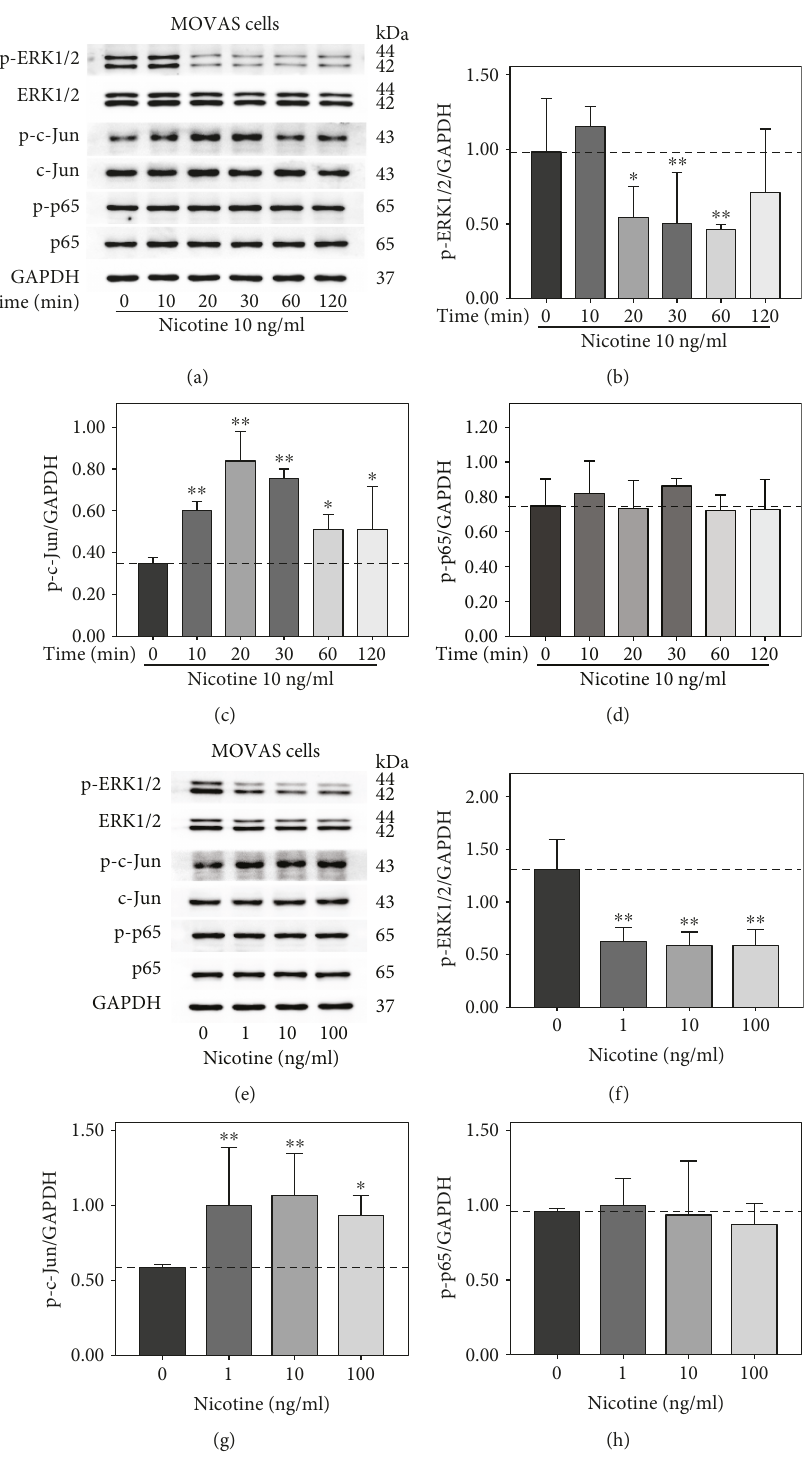
Figure 3: Nicotine increased the phosphorylation of c-Jun in MOVAS cells. (a) MOVAS cells were exposed to 10 ng/ml nicotine for 0, 10, 20, 30, 60, and 120 min. (e) MOVAS cells were treated with nicotine for 30min at the concentrations of 0, 1, 10, and 100 ng/ml. The expression of phosphorylated extracellular signal-regulated kinase1/2 (p-ERK1/2), ERK1/2, p-c-Jun, c-Jun, p-p65, and p65 were analyzed with Western blot. (b – d, f – h) Densitometric analysis of protein bands was performed via ImageJ software. GAPDH was utilized as an internal control, and all experiments were analyzed as three di ff erent independent experiments. ∗ p < 0 05 and ∗∗ p < 0 01 versus